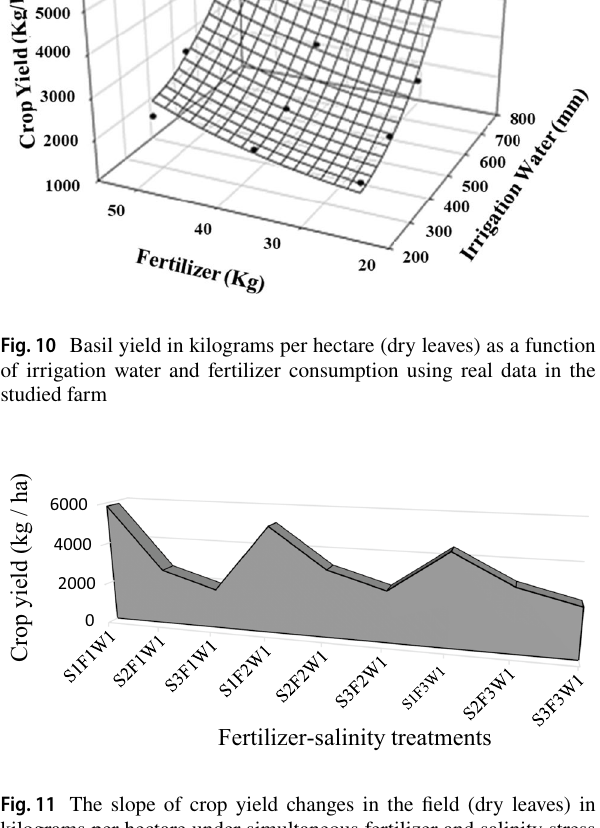
Fig. 11 The slope of crop yield changes in the field (dry leaves) in kilograms per hectare under simultaneous fertilizer and salinity stress conditions